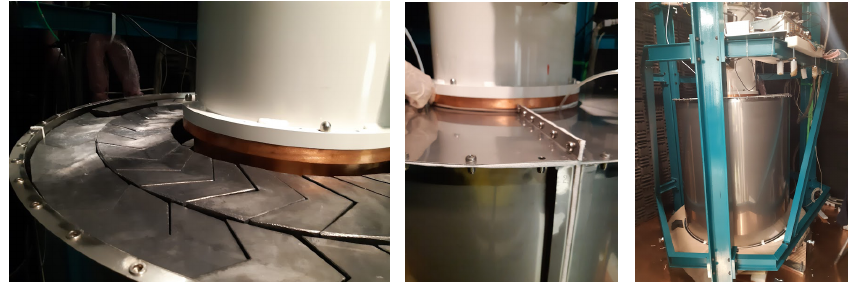
Figure 25. CROSS Anti-Radon